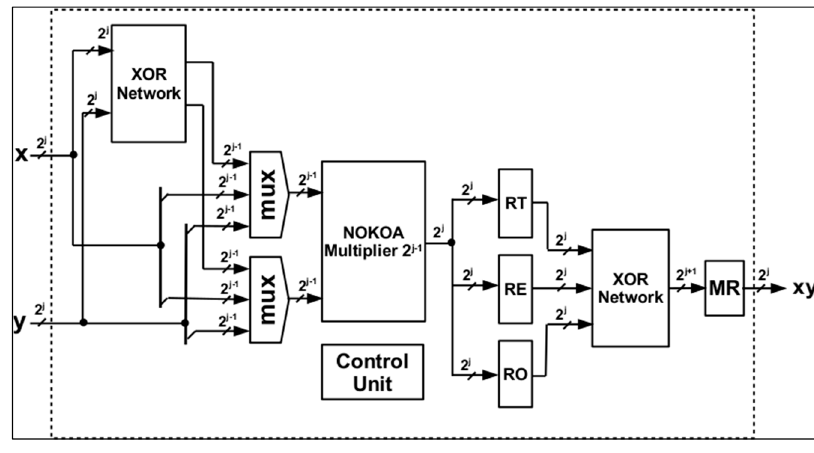
Figure 4. Internal architecture of RNOKOA11C field multiplier unit.